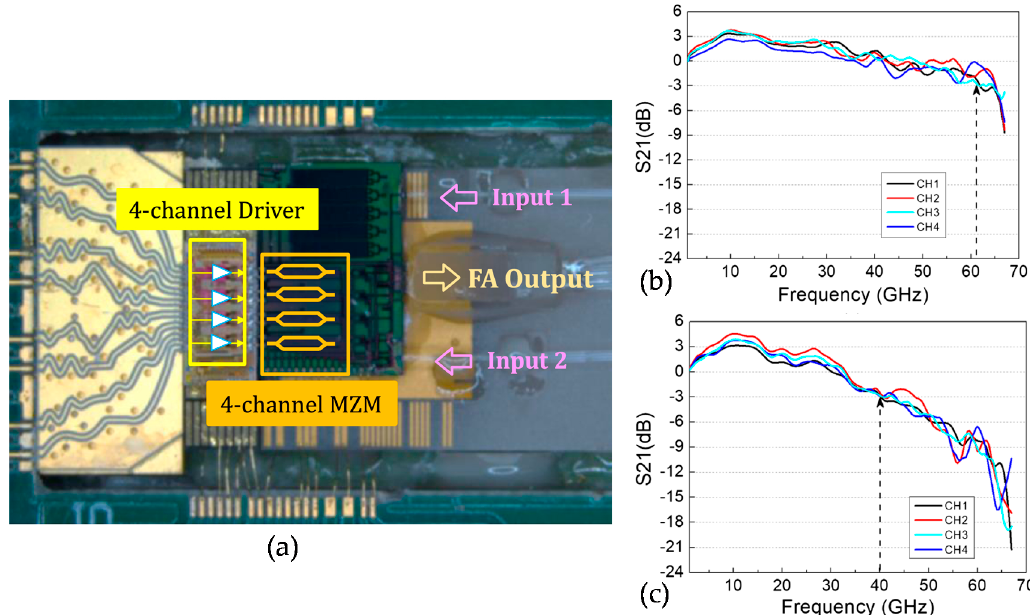
Figure 4. ( a ) Micrograph of the chip-on-board silicon photonics transmitter; ( b ) S 21 characteristics of silicon photonics modulator under different channels (e.g., CH_1, CH_2, CH_3, and CH_4); ( c ) S 21 characteristics of transmitter co-packaged with the driver under different channels. FA: fiber array; (From [88] © 2021 Chinese Laser Press). Table 5. Incomplete summary of monolithic integrated transmitters applied in beyond 100-Gbit/s per lane data transmission. Tx